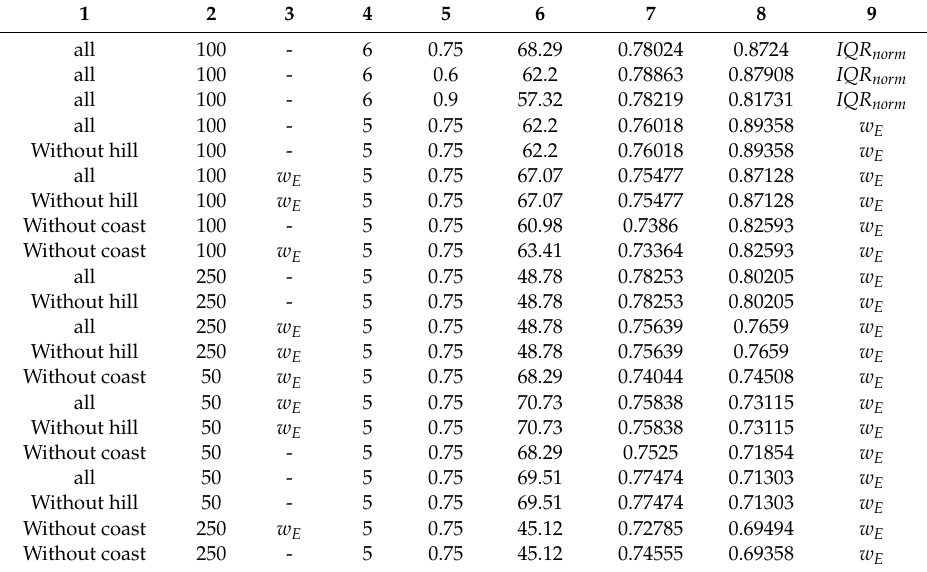
Table A2. Table of model results calculated to test and compare bu ff er sizes, weightings and variables. (Due to geometry restrictions the header items are abbreviated and stated here: 1—Variable